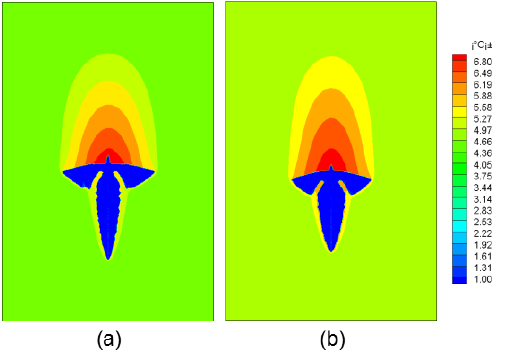
Figure4. Dendriticmorphologyevolutiondiagramunderdi ff erentmethods. ( a )Method1; ( b Figure 4. Dendritic morphology evolution diagram under different methods. ( a ) Method 1; ( b ) Method 2.